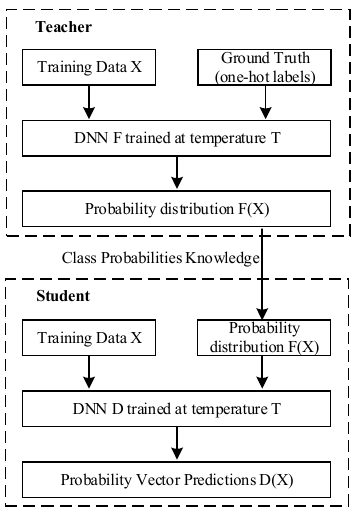
Figure 4. Defense mechanism based on Distillation. The mechanism consists of a teacher model and a student model. The student is trained with the output classification probability of the